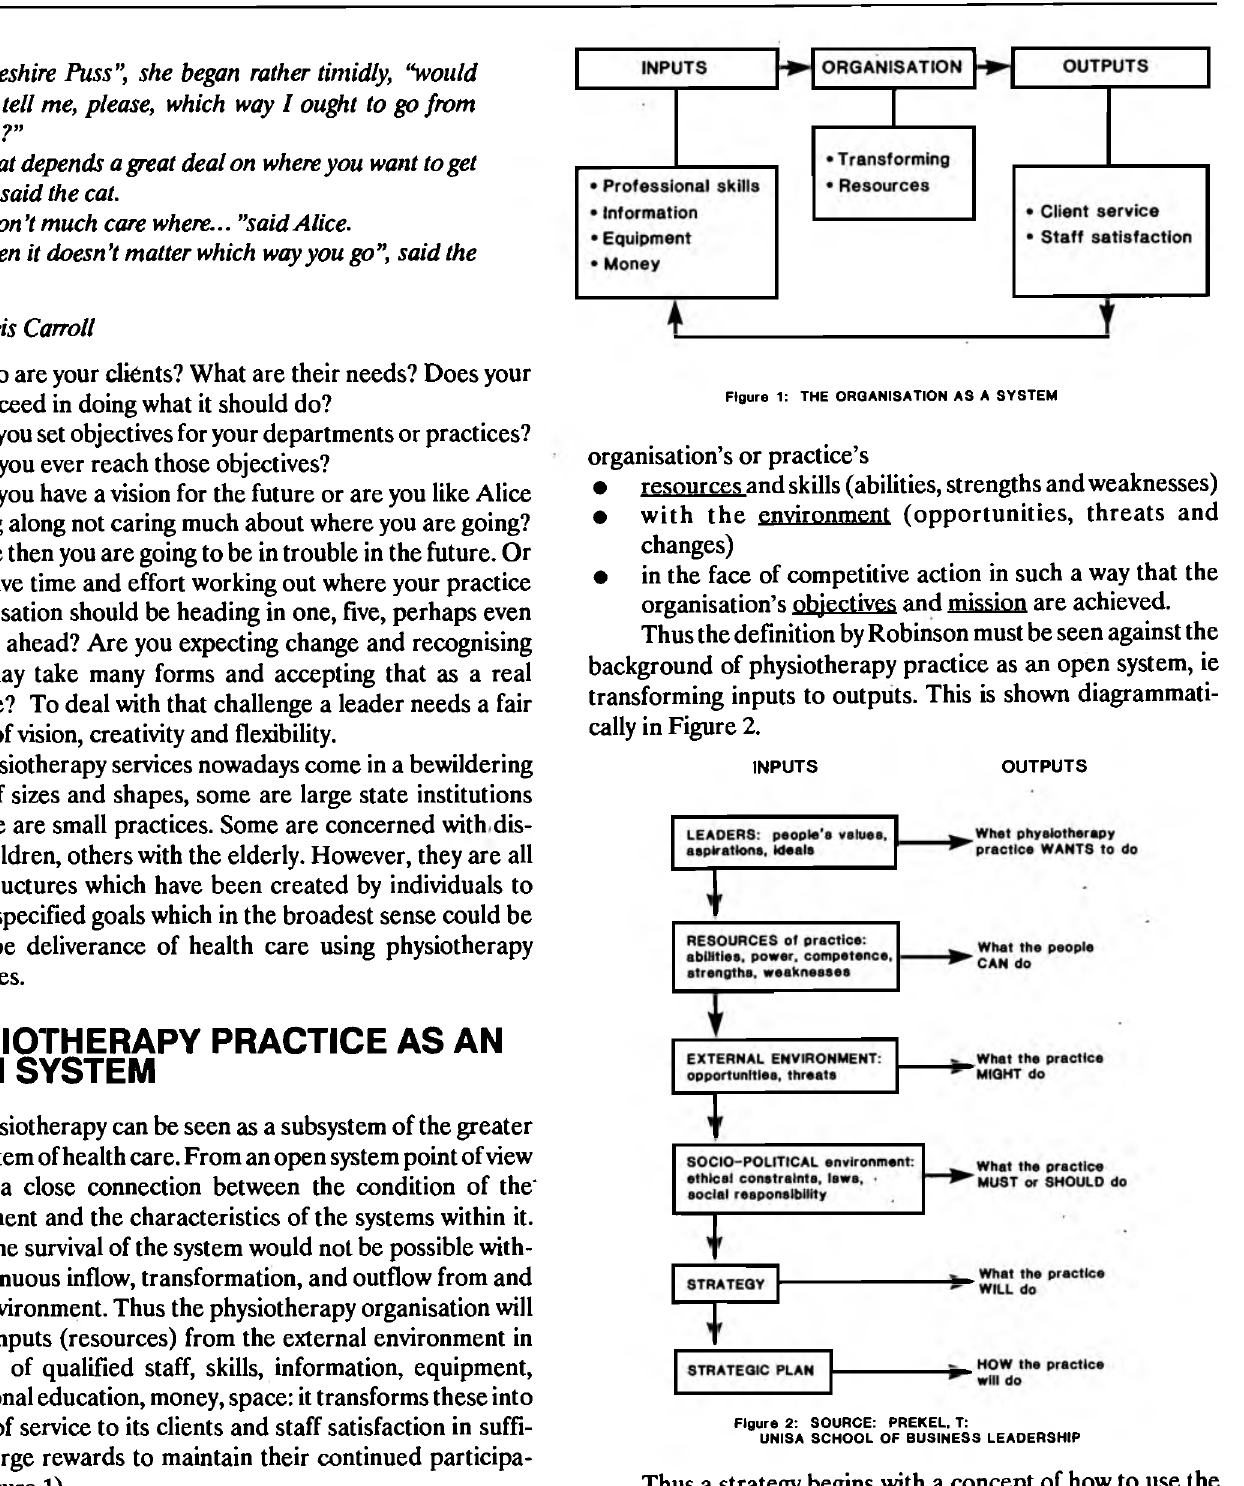
Figure 2: SOURCE: PREKEL. T: UNISA SCHOOL OF BUSINESS